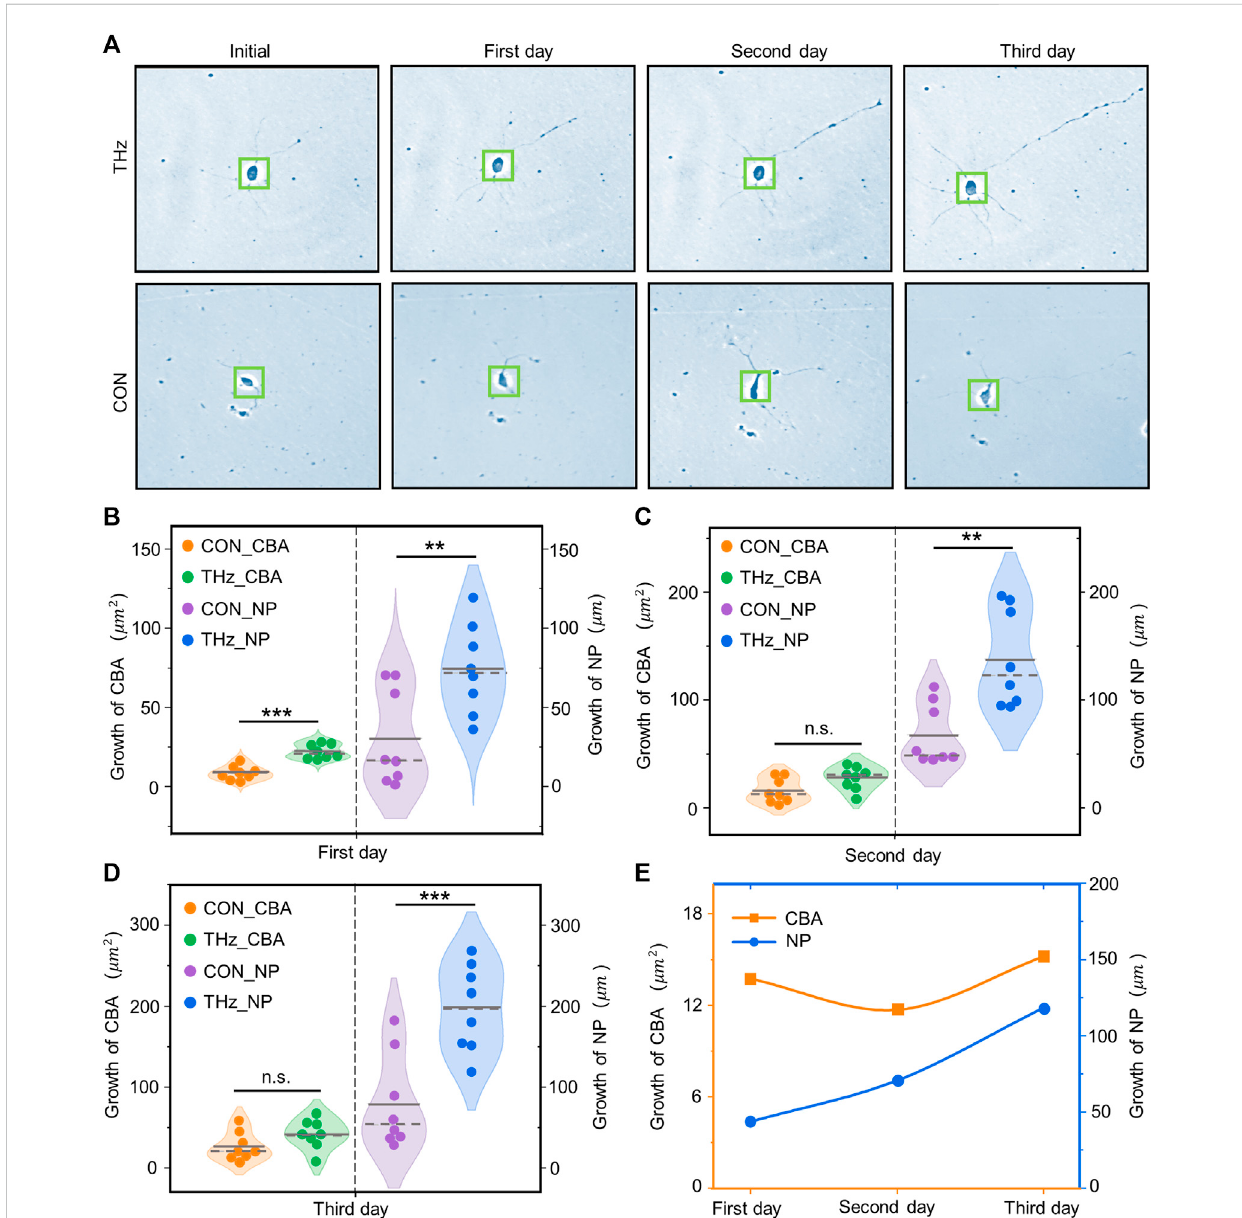
FIGURE 5 Broadband terahertz radiation promotes the dynamic growth and development of cortical neurons. (A) Representative performance maps of neuronal developmental status in the Terahertz (THz) and Control (CON) groups. (B – D) Signi fi cance analysis of the difference between THz and CON in terahertz cumulative radiation neurons for 3 days. On the fi rst day, neurite protrusion (NP) and cell body area (CBA) were signi fi cantly higher than the CON. On the second day NP was signi fi cantly higher than the CON, but CBA showed no signi fi cant difference. On the third day, there was no signi fi cant difference between CBA and CON, but NP was signi fi cantly higher than the CON. Data are mean ± SEM (n = 8 independent experiments). **, p < 0.01).***, p < 0.001 comparedwith CON,independentsamples t -test. (E) Relationshipbetweentheradiation daysinTHZ_CBA minusCON_CBA and THZ_NP minus